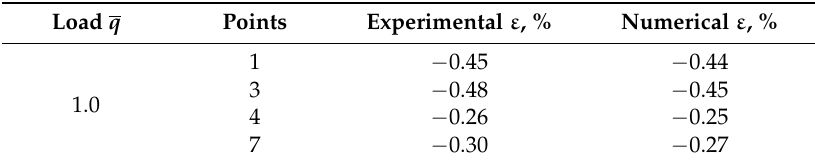
Table 3. Longitudinal strains ε near damage zone ( q —dimensionless